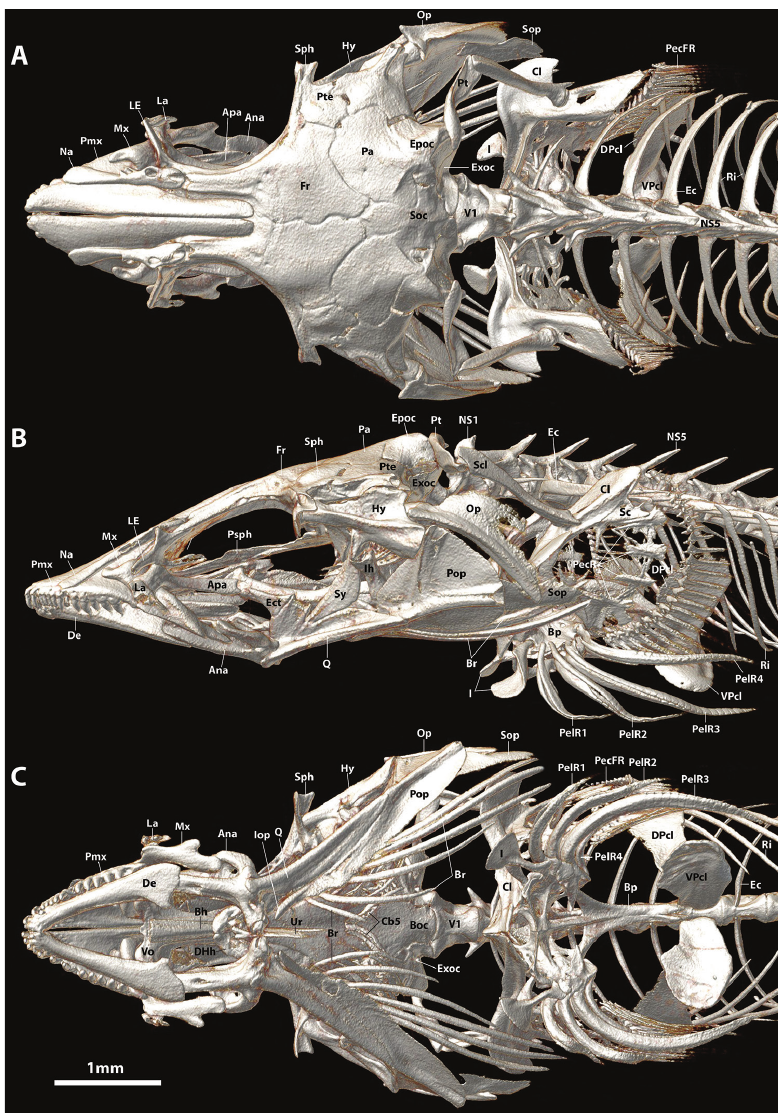
Figure 14. CT scanned anterior skeleton of Aspasmogaster costata , TCWC 17166.01, 30.0 mm SL. A Dorsal view B Lateral view (left side) C Ventral view. Abbreviations: ACh, anterior ceratohyal; Ana, anguloarticular; Apa, autopalatine; Boc, basioccipital; Bp, basipterygium; Br, branchiostegal rays; Cb5, ceratobranchial 5; Cl, cleithrum; DHh, dorsal hypohyal; DPcl, dorsal postcleithrum; Ec, epicentral; Ect, ectopterygoid; Epoc, epiotic; Exoc, exoccipital; Fr, frontal; Hy, hyomandibular; I, pelvic-fin spine; Iop, interopercle; La, lachrymal; LE, lateral ethmoid; Na, nasal; NS1, 5, neural spine of vertebral centrum 1, 5; Op, opercle; Pa, parietal; PecR, pectoral radial; PecFR, pectoral-fin ray; PelFR1-4, pelvic-fin ray 1–4; Pop, preopercle; Pro, prootic; Psph, parasphenoid; Pt, posttemporal; Pte, pterotic; Q, quadrate; Ra, ret- roarticular; Ri, rib; Sc, scapula; Scl, supracleithrum; Soc, supraoccipital; Sop, subopercle; Sph, sphenotic; Ur, urohyal; V1, vertebral centrum 1; Vo, vomer; VPcl, ventral